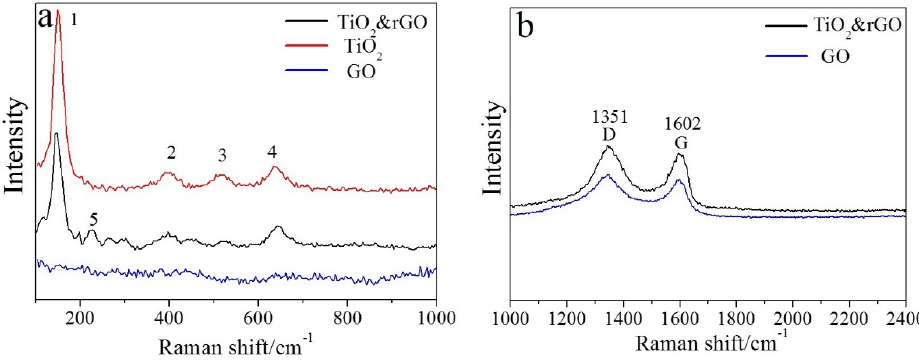
Figure 7. Raman spectra of ( a ) TiO 2 and ( b ) rGO.